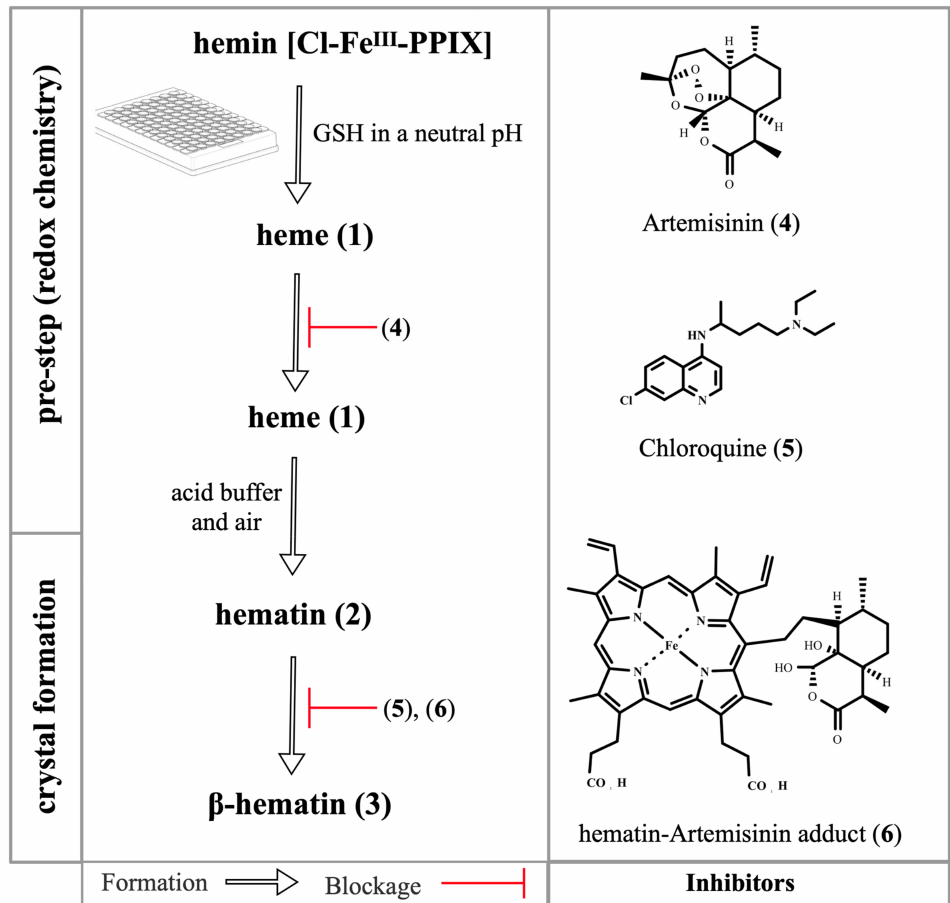
Figure 5. Overview of the β -hematin crystal formation and drug blockage. A typical assay employs hematin ( 3 ) as a starting reactant, but to assess the redox chemistry, a pre-step is employed, where hemin chloride is reduced by glutathione (GSH) into heme ( 1 ). Upon addition of an acid buffer and exposure to air, heme ( 1 ) is oxidized back to hematin ( 2 ) and is gradually dimerized into β -hematin dimers ( 3 ) to form crystals (not depicted here) [40,48]. The artemisinin ( 4 ) alkylates the heme ( 1 ) and the hematin–artemisinin adduct ( 6 ) is formed. The adduct ( 6 ) and 4-aminoquinolines in general, exemplified here by chloroquine ( 5 ), bind to hematin ( 2 ) and inhibit its dimerization ( 3